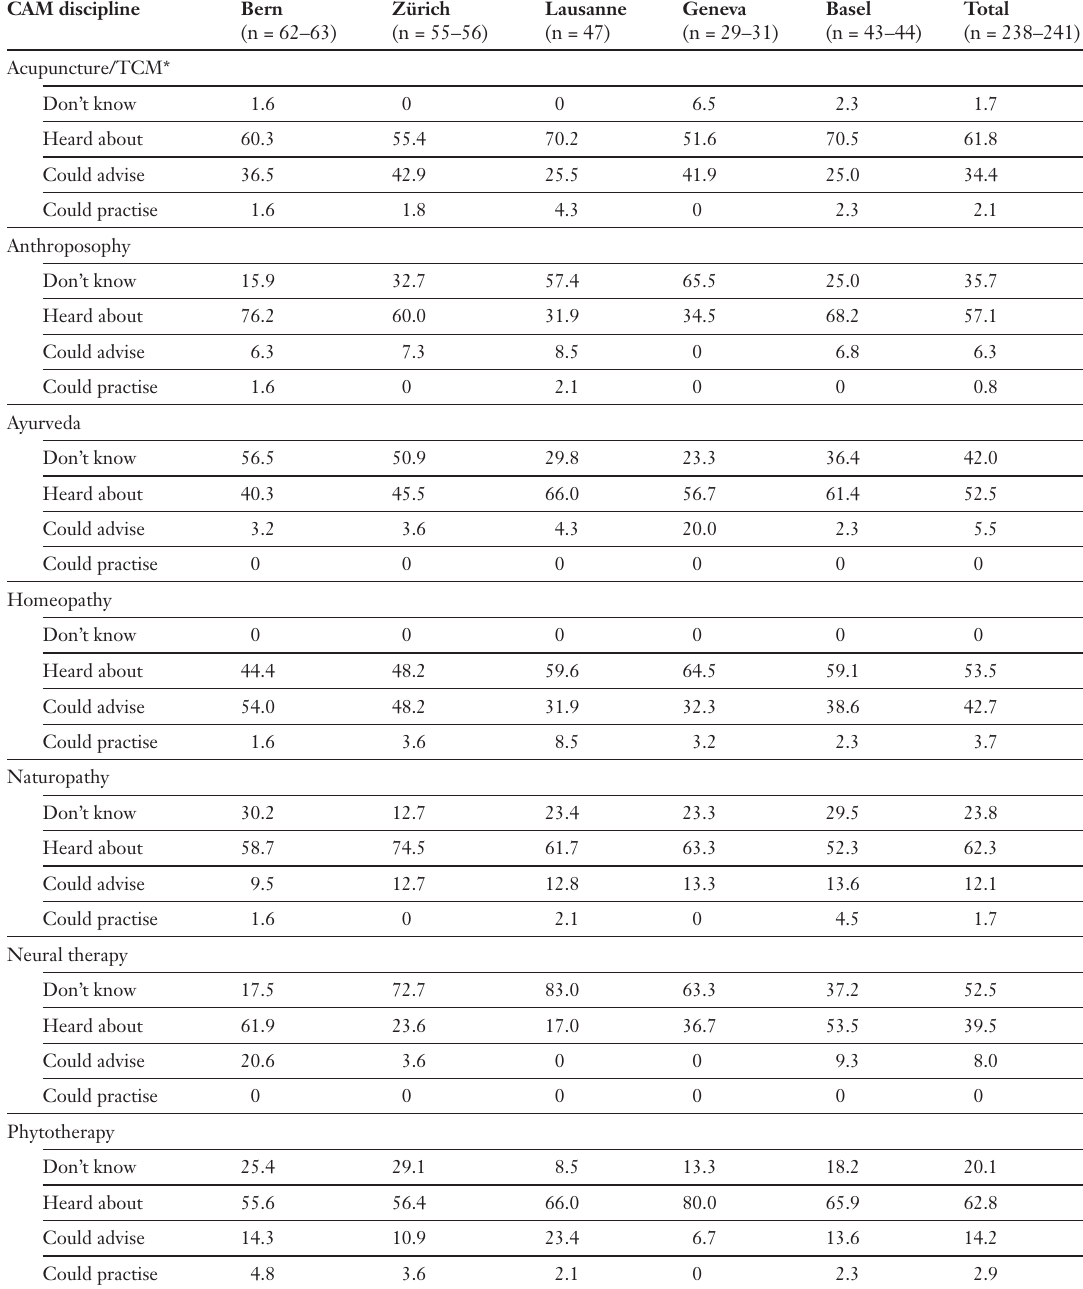
Table 7 Students’ self- assessed knowledge of CAM